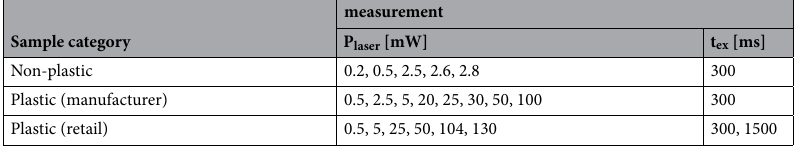
Table 4. Summary of samples and measurement parameters. For each sample, the laser power ( P laser ), the exposure time ( t ex ) were